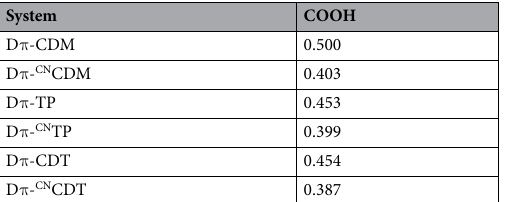
Table 6. The calculated integral area between anchoring group and two surface Ti